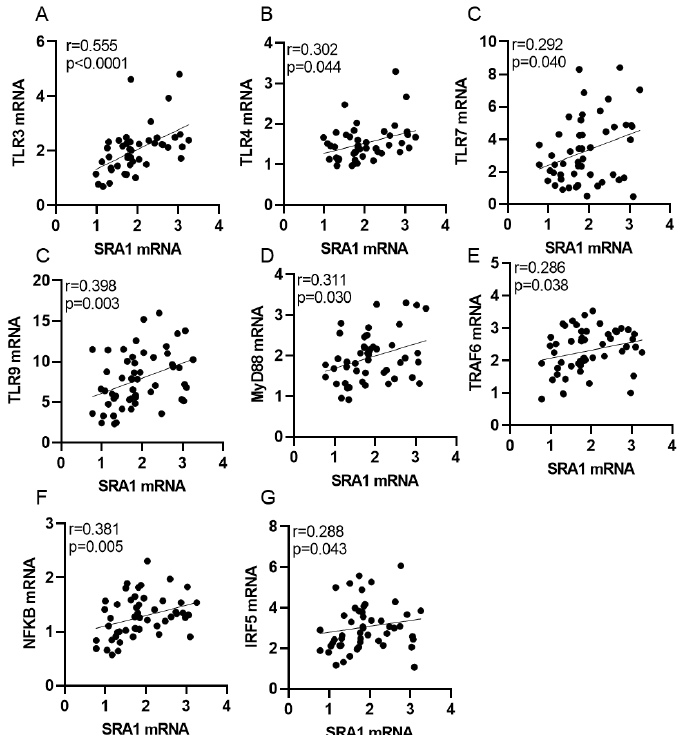
Figure 7. SRA1 gene expression is correlated with TLR3, TLR4, TLR7, TLR9, Myd88, TRAF6, NF-kB or IRF5 in the adipose tissues obtained from individuals with T2D ( A – G ). 3.4. Analysis of the Independent Associations between SRA1 and TLRs, Their Signaling Mediators, and IRFs In order to determine independent associations, the markers showing significant as- sociations with adipose SRA1 expression were further assessed by multivariable stepwise linear regression analysis (Table 5). We found that in the total population (N = 108), TLR3 and IRAK1 independently predicted the adipose SRA1 expression. In participants with T2D (N = 53), TLR3 and TLR9 were identified as the independent predictors of adipose SRA1 expression, but not in participants without T2D (N = 55). Regression analysis strati- fied by obesity status revealed the independent association of adipose SRA1 expression with MyD88 in NW (N = 12), and with TLR9 in overweight (N = 32) participants. In indi- viduals with obesity (N = 64), TLR3, TLR7 and IRAK1 were detected as the independent predictors of adipose SRA1 expression.